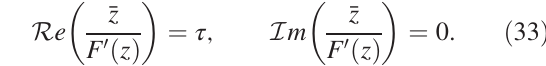
x Þ plane has a y Þ